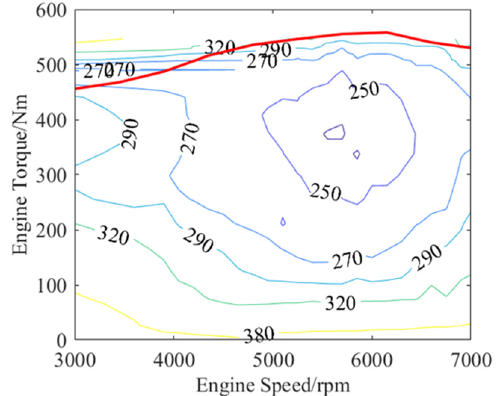
Figure 2. Fuel consumption map of the turboshaft